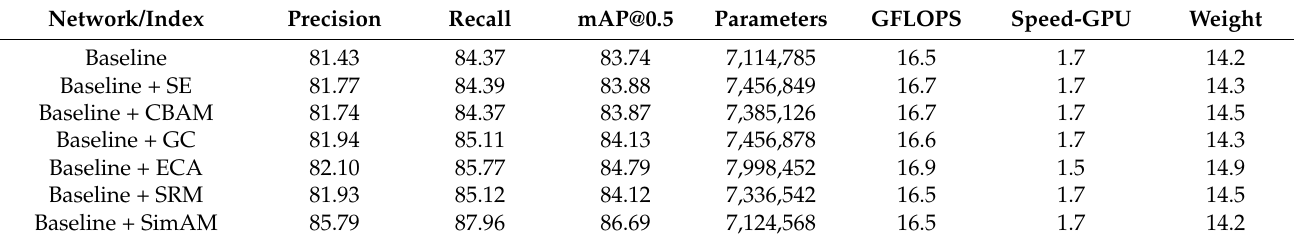
Table 2. Performance comparison of YOLOv7 with different attention